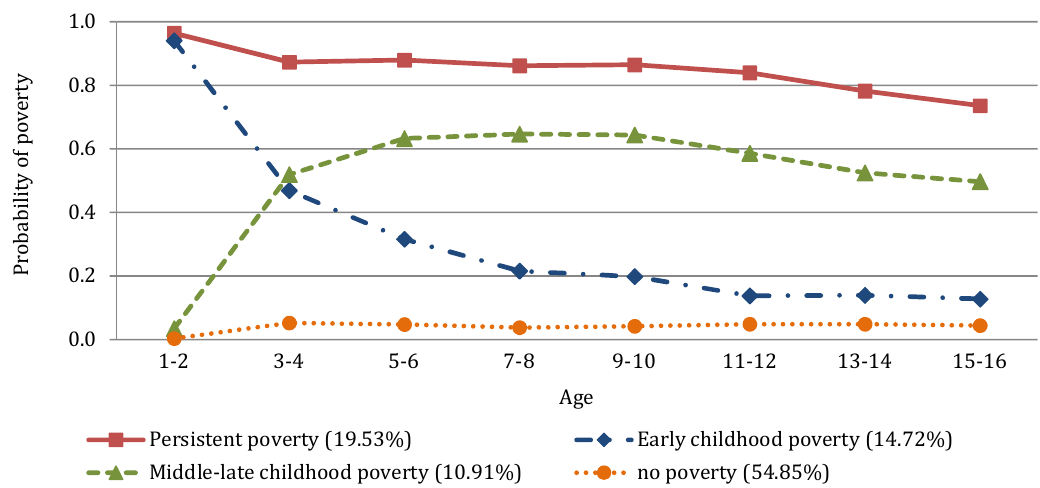
Figure 3 . Trajectories of Exposure to Poverty during Childhood Figure 3: Trajectories of Exposure to Poverty during Childhood